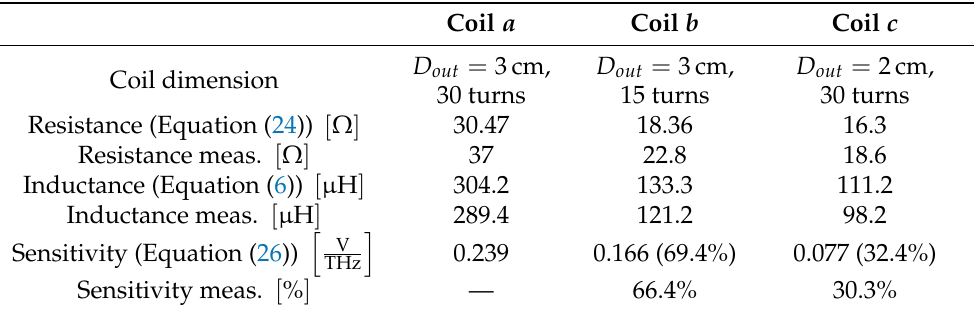
Table 1. Coil resistance and self inductance predicted and measured at 1kHz, for the three coils of Figure 8. Sensitivity predicted by Equation (26) and signal variation experimentally measured between the three